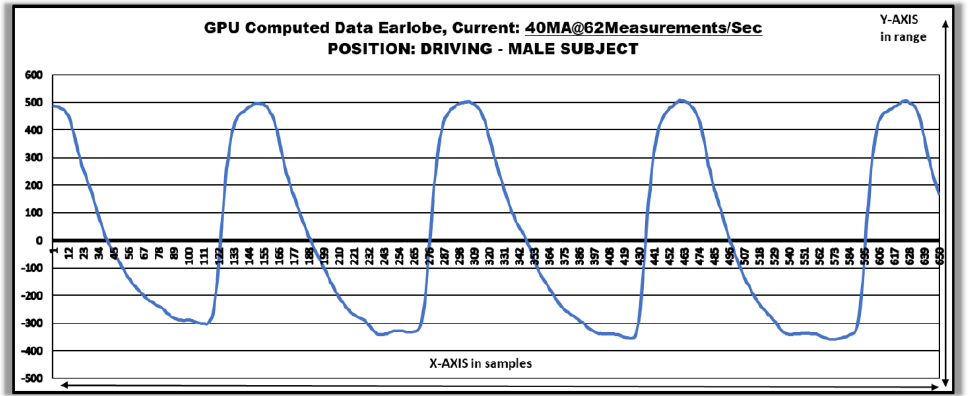
Figure 14. GPU-Computed Data using Earlobe.